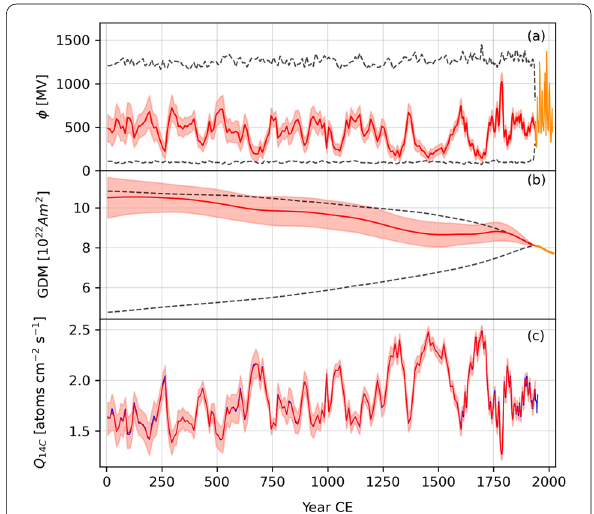
Fig. 9 Solar activity and GDM reconstructed by the Bayesian model for the last 2000 years. Posterior distributions of solar activity ( a ) and GDM ( b ) are depicted with mean (red lines) and 2-sigma uncertainty of a thousand realizations (light red shadings). The 2-sigma uncertainty of a thousand realizations from the prior distributions are indicated by two black dashed lines. Panel c shows the mean (red line) and 2-sigma posterior uncertainty (light red shading) of a thousand curves of 14 C production rate generated by the recovered φ and M . The input mean 14 C production rate is represented by the blue line. The uncertainty of the input 14 C production rate (not shown in the figure) is similar to the posterior uncertainty (light red shading). Figure 2 shows the uncertainty of the input 14 C production rate before